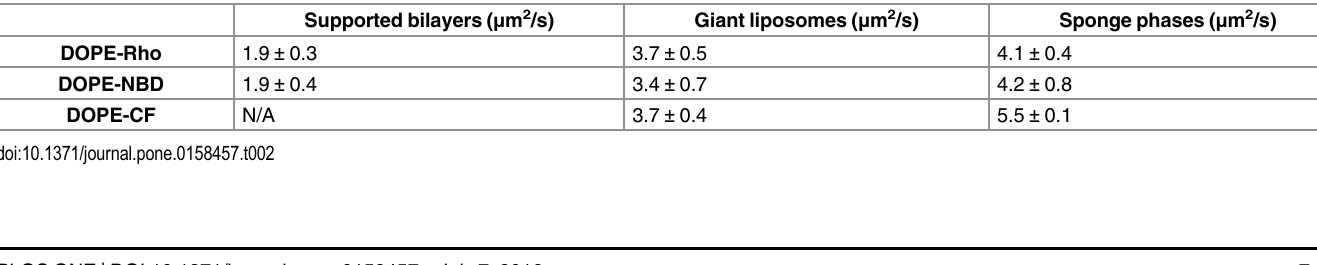
Table 2. Diffusion coefficient of various headgroup-labeled DOPE lipids in different artificial membrane environments. Two-sample t -tests: sup- ported lipid bilayers vs. giant liposomes (p < 0.01); supported lipid bilayers vs. sponge phases (p < 0.001); giant liposomes vs. sponge phases